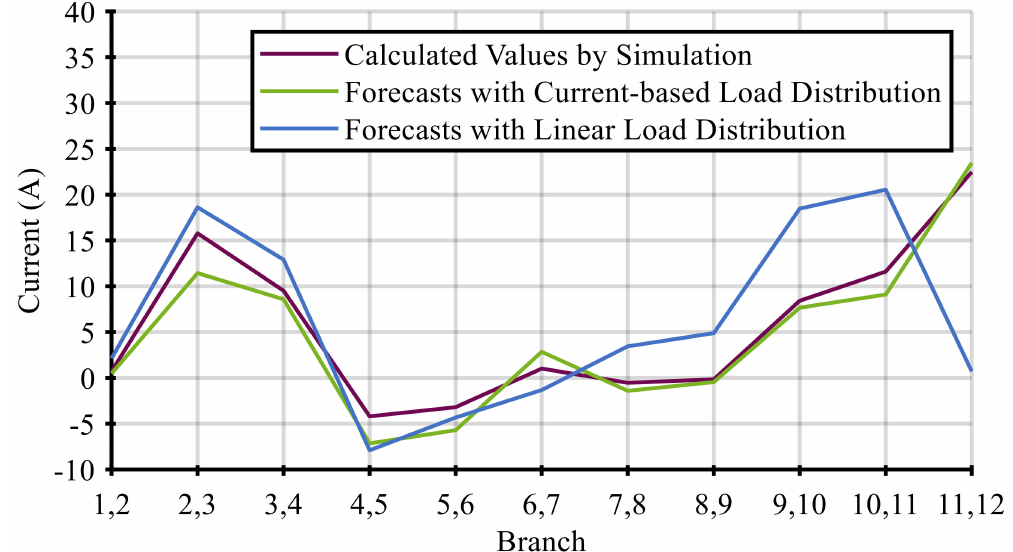
Figure 9. Simulated branch currents in comparison to the forecasts at one time